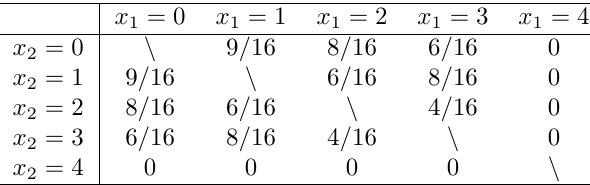
Table 7: Probability of 2 bits